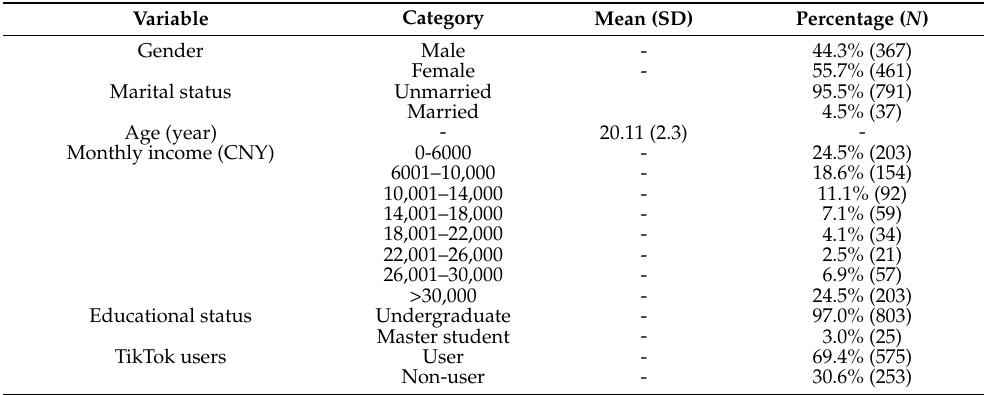
Table 1. Participants’